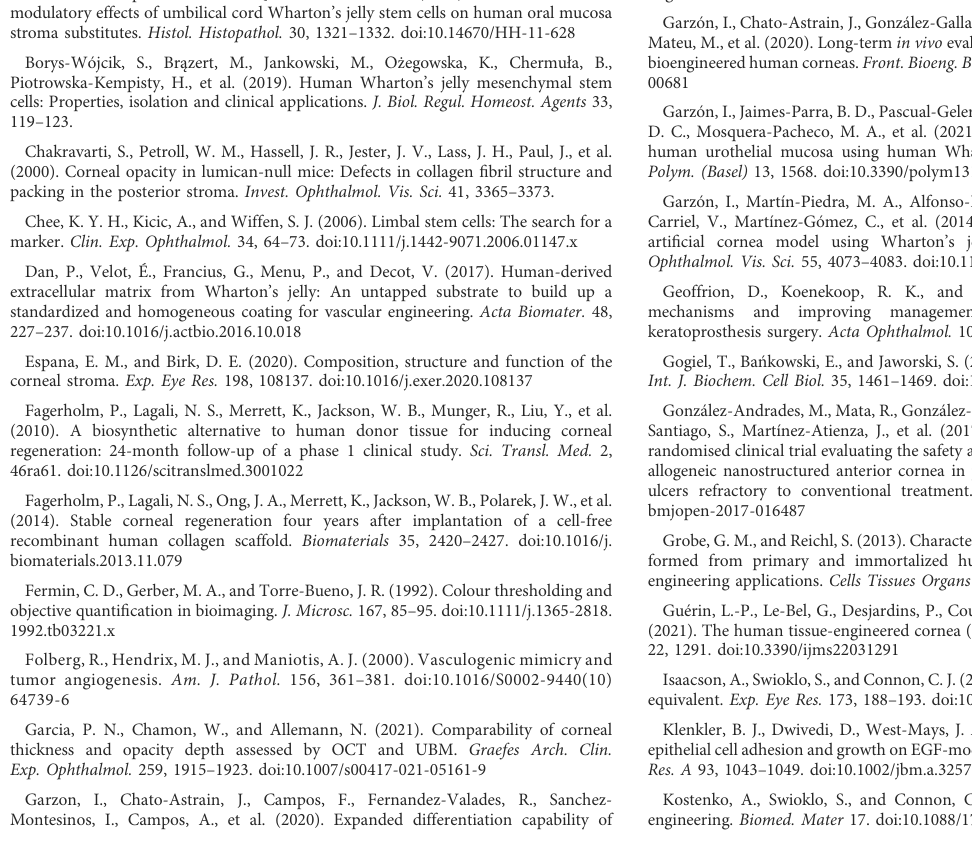
SUPPLEMENTARY FIGURE S1 Immuno fl uorescence analysis of the OAC and HAC tissues kept ex vivo and grafted in vivo and control native human corneas (H) and rabbit corneas (R) using an anti-human mitochondria primary antibody. Scale bar: 50 µm (applicable to all